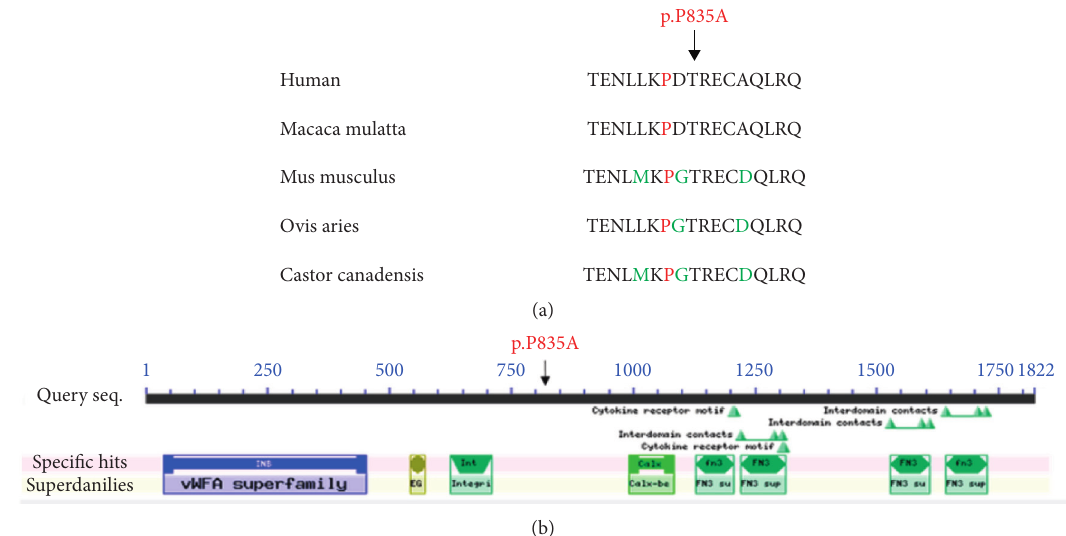
Figure 5: (a) Affected amino acid residue of ITGB4 highly conserved between different species. (b) Conserved domains in fatty acid